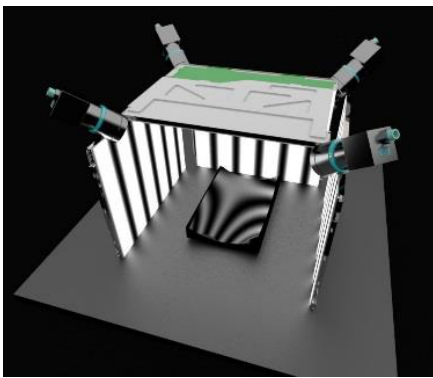
Figure 4 . Rendering of deflectometry system at Optimax. Form and surface position is adjusted using CMM feedback down to a few micrometers of residual error.